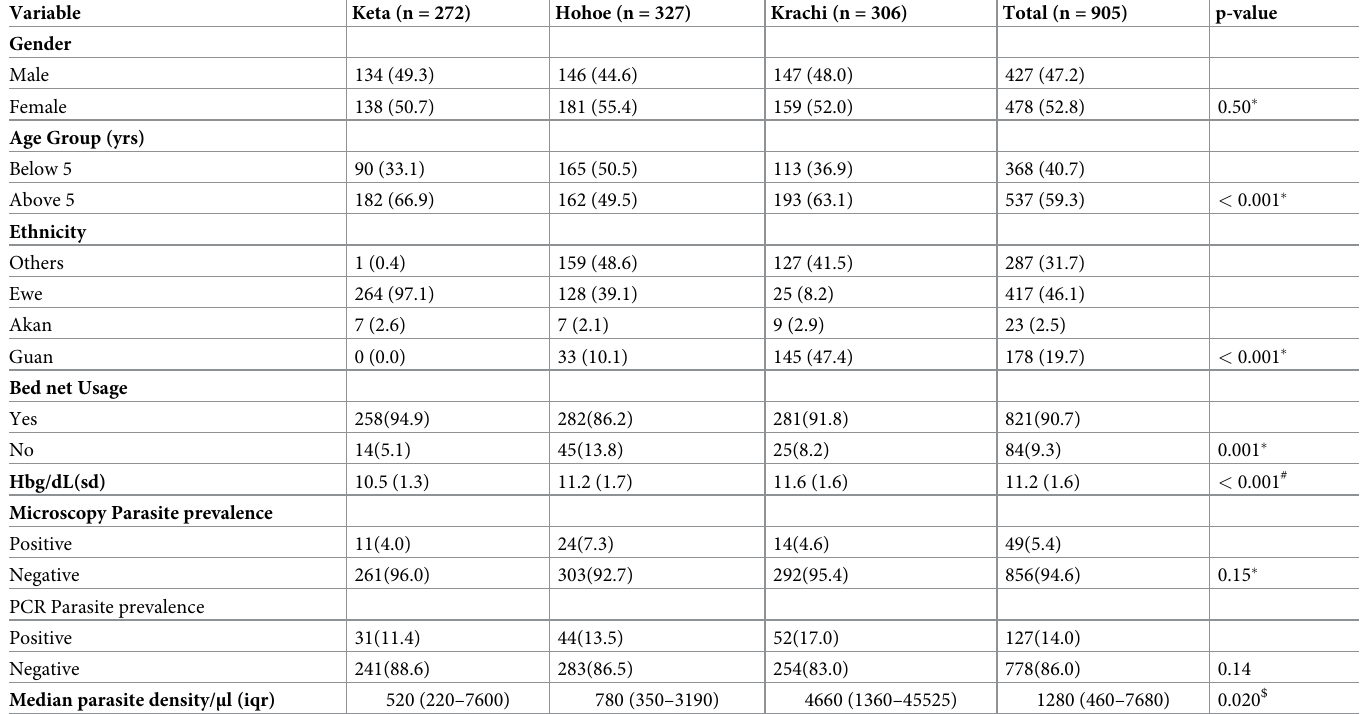
Table 1. Characteristics of study